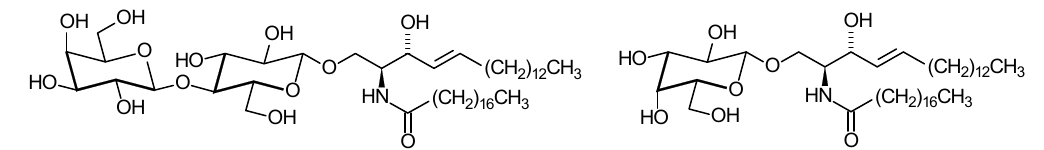
Figure 1. Structures of lactosylceramide and galactosylceramide. Only one of the various lipoforms is